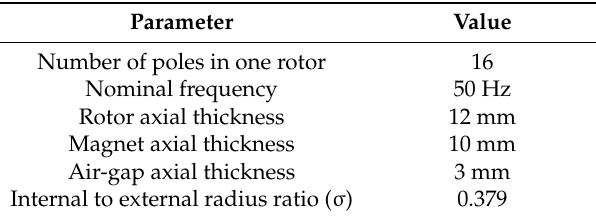
Table 1. Basic machine parameters.